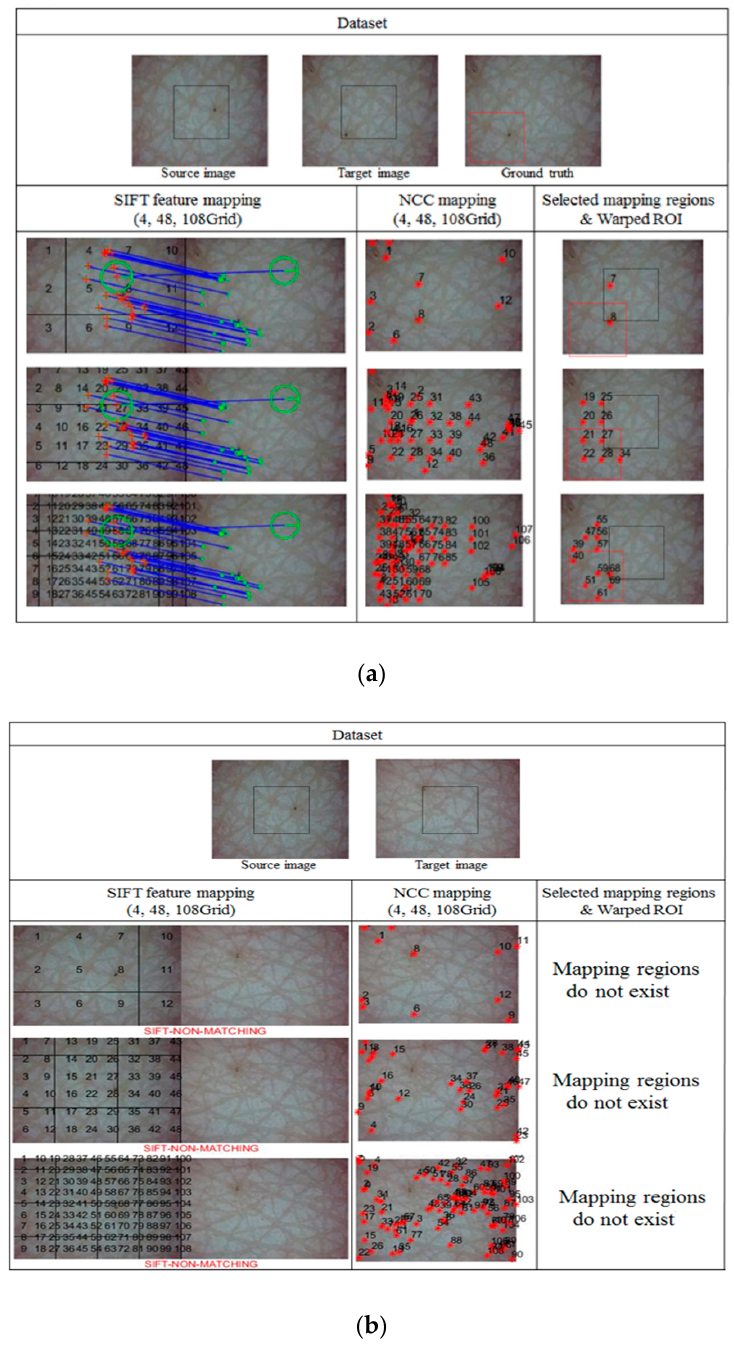
Figure 11. Example of ROI warping results—( a ) matched case; ( b ) non-matched case.